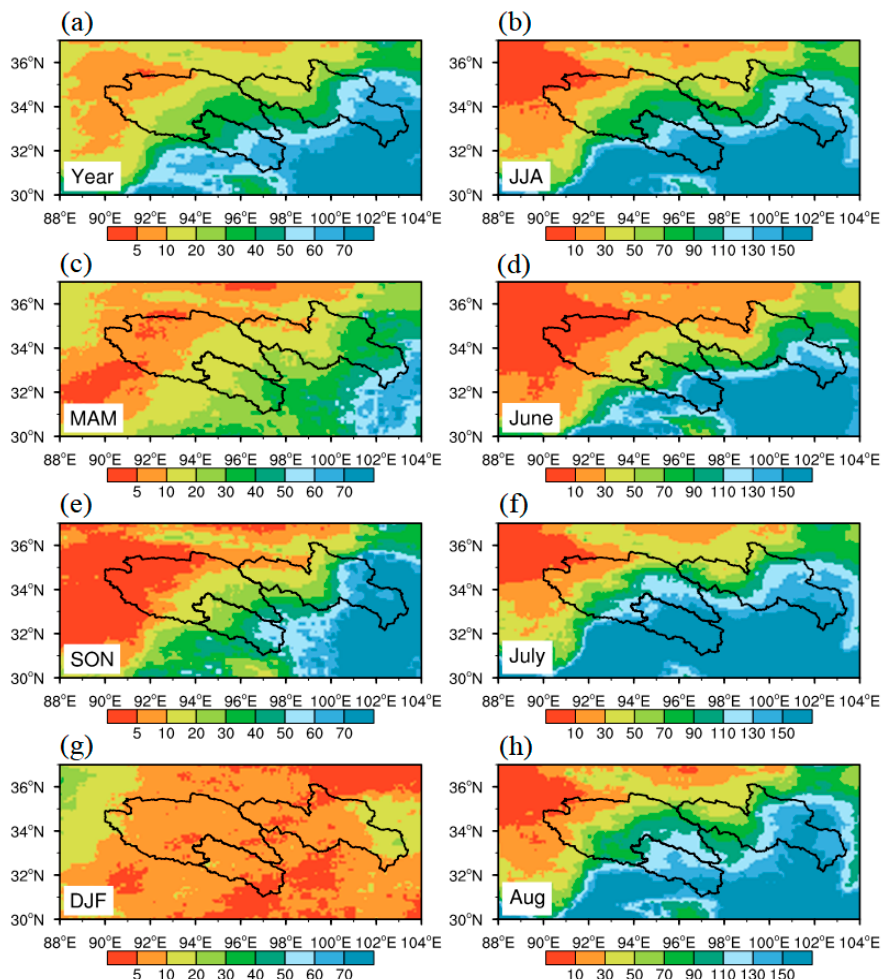
Figure 2. Precipitation (mm/month) in ( a ) annual average, ( b ) June-July-August (JJA) average, ( c ) March-April-May (MAM) average, ( d ) June average, ( e ) September-October-November (SON) average, ( f ) July average, ( g ) December-January-Februrary (DJF) average, and ( h ) August average from 2001 to 2019.